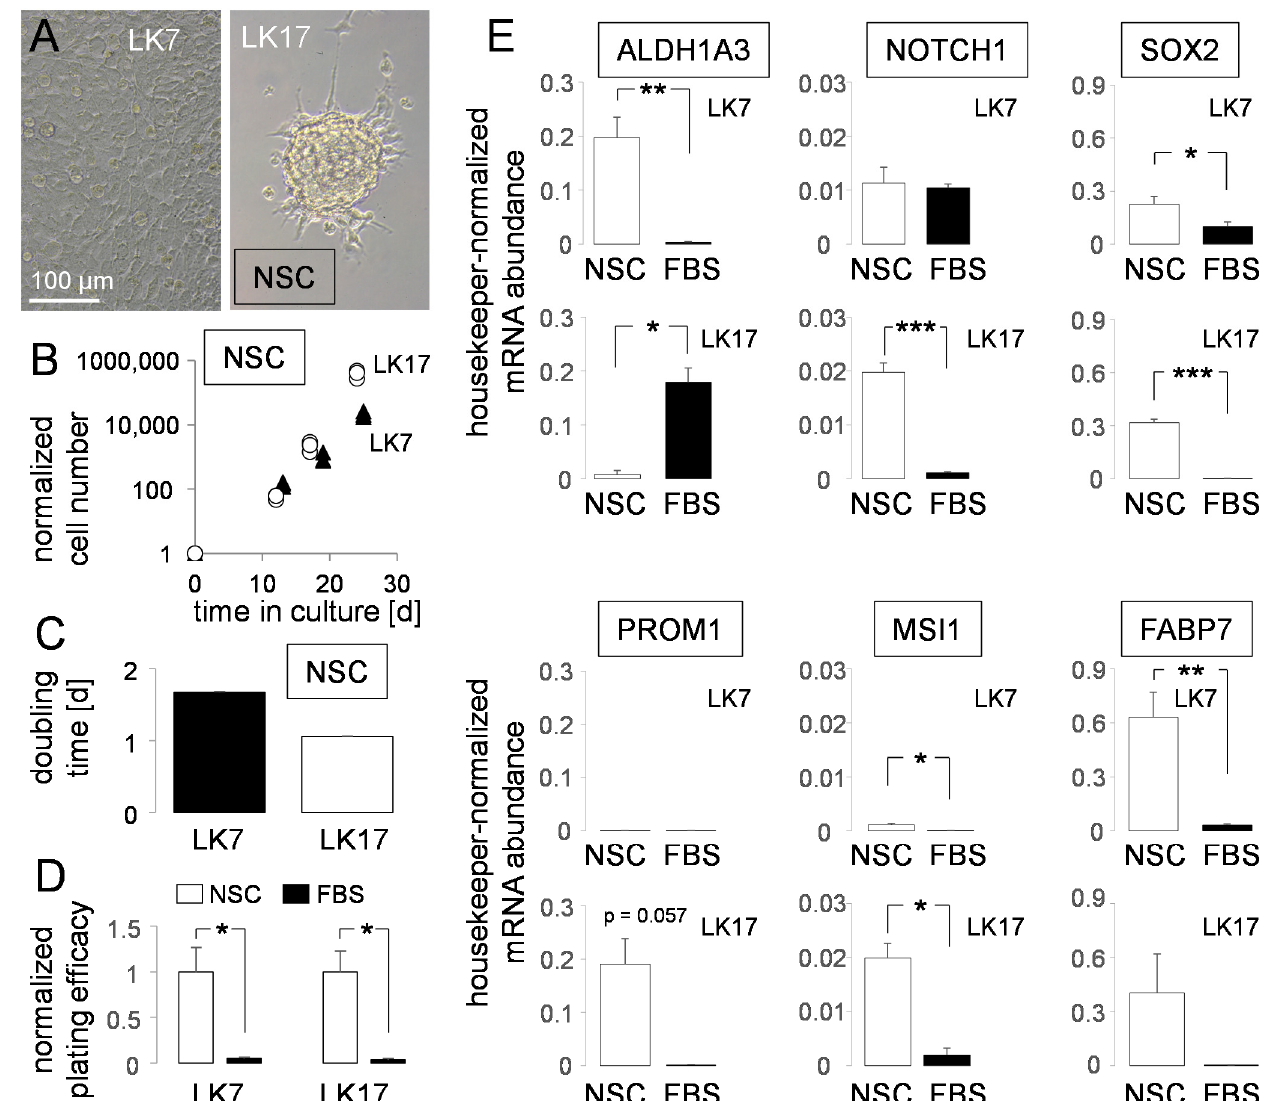
Figure 1. Stem-cell properties of LK7 and LK17 pGSCs. ( A ) Light micrographs showing the growth phenotype of LK7 (left) and LK17 (right) pGSCs. ( B , C ) Mean ( ± SE, n = 3) cell number ( A ) and doubling time ( B ) of LK7 (closed symbols/bar) and LK17 (open symbols/bar) cells during exponential growth in NSC medium. ( D ) Mean ( ± SE, n = 4) normalized plating efficiencies as a measure of clonogenicity of LK7 (left) and LK17 (right) pGSCs grown in NSC (open bars) and tumor “bulk” cell-differentiating FBS-containing medium. ( E ) Mean ( ± SE, n = 3–8) housekeeper-normalized abundance of mRNAs encoding stemness markers (as indicated) in LK7 (1st and 3rd line) and LK17 pGSCs (2nd and 4th line) grown in stem-cell-enriching NSC medium (open bars) or upon FBS-mediated “differentiation” into “bulk” tumor cells in 10% FBS/RPMI-1640 medium (closed bars). *, ** and *** indicate p ≤ 0.05, 0.01 and 0.001, respectively, Welch-corrected two-tailed t -test.